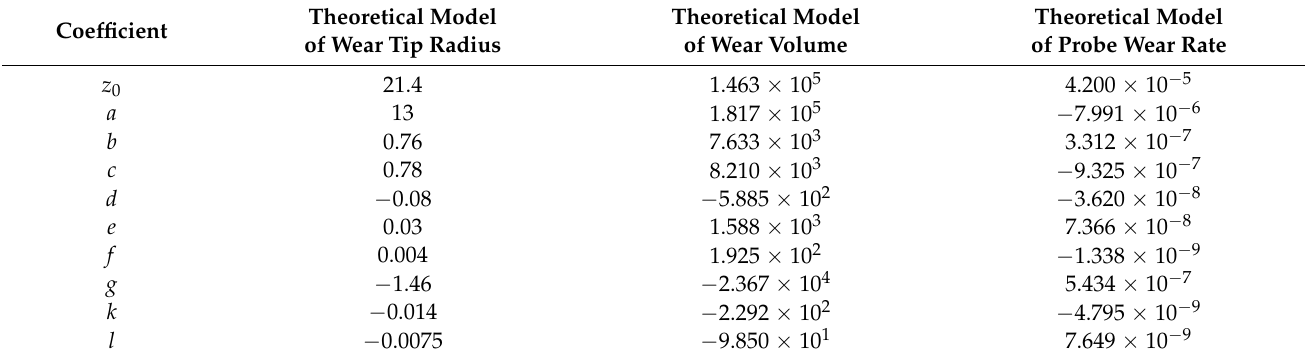
Table 5. Coefficients of the theoretical